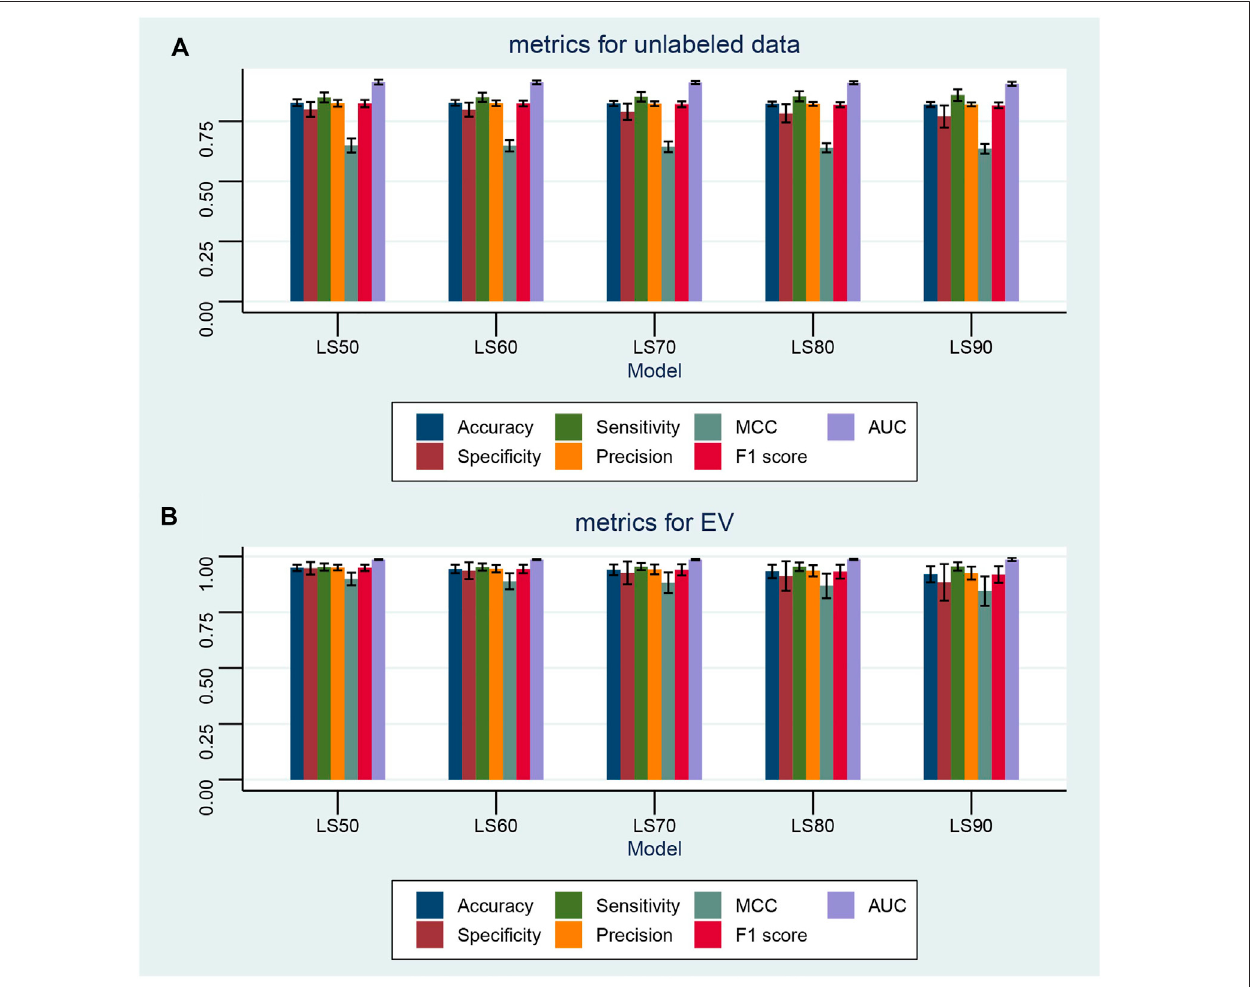
FIGURE8 | Performance ofthe semi-supervised machine learning model withvarious ratios ofunlabeleddata. Semi-supervised machine learning models arebuilt with the label spreading (LS) algorithm. The ratios of randomly unlabeled samples include 50% (LS50), 60% (LS60), 70% (LS70), 80% (LS80), and 90% (LS90). In each ratio, the semi-supervised model is cross-validated 100 times by random permutation. (A,B) Performance of the semi-supervised machine learning models on all unlabeled data and the valid dataset with various ratios of unknown samples, respectively. Seven metrics are given, namely, accuracy, F1 score, MCC, precision, sensitivity, speci fi city, and